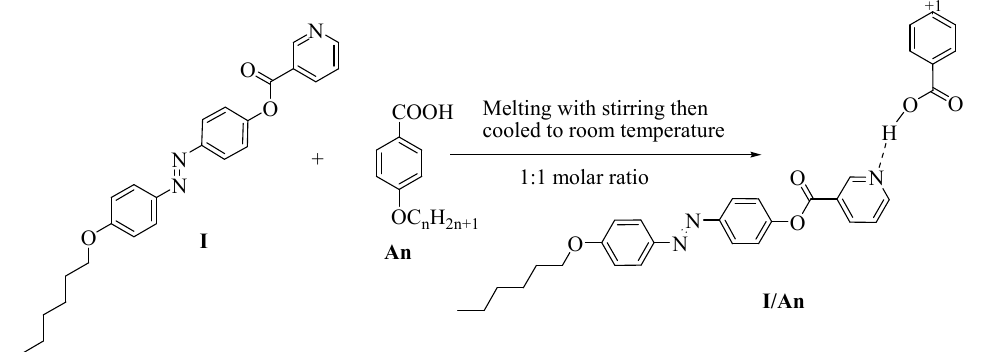
of the H -bond between the nitrogen atom of base and the COOH group of acid replaces the dimeric H -bonds of the 4-alkoxybenzoic